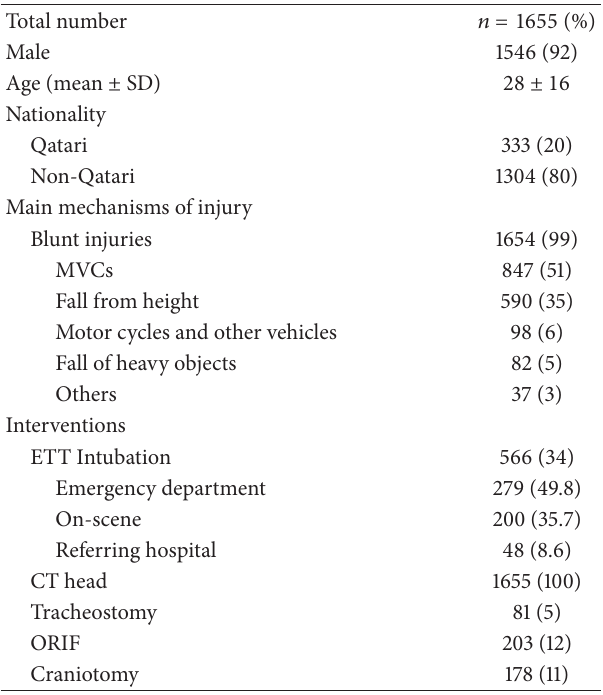
Table 1: Demographics, injury mechanism, and interventions in TBI patients.